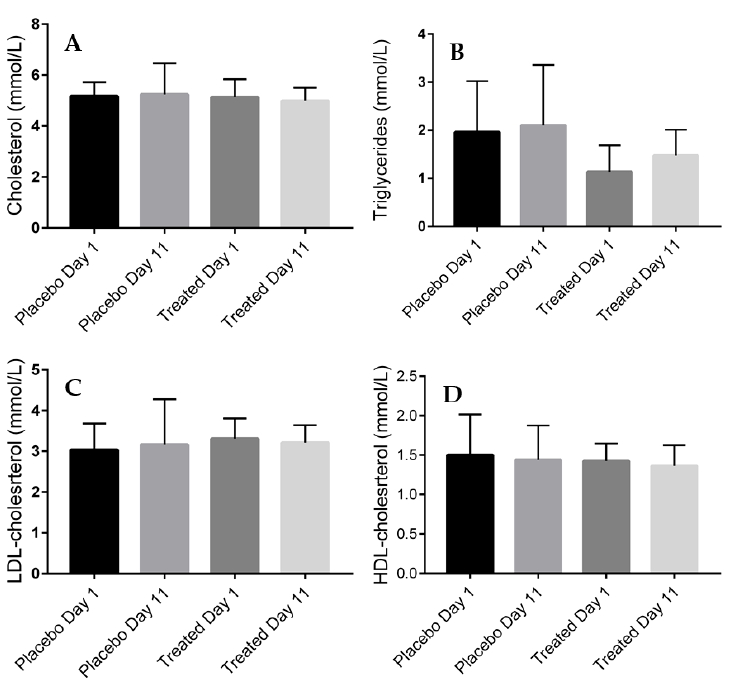
Figure 4. Serum lipid levels of the placebo- and fenugreek-treated subjects. ( A ) serum total-cholesterol levels (mmol/L); ( B ) serum triglyceride levels (mmol/L); ( C ) high-density lipoprotein (HDL)-cholesterol levels (mmol/L); ( D ) low-density lipoprotein (LDL)-cholesterol levels (mmol/L).